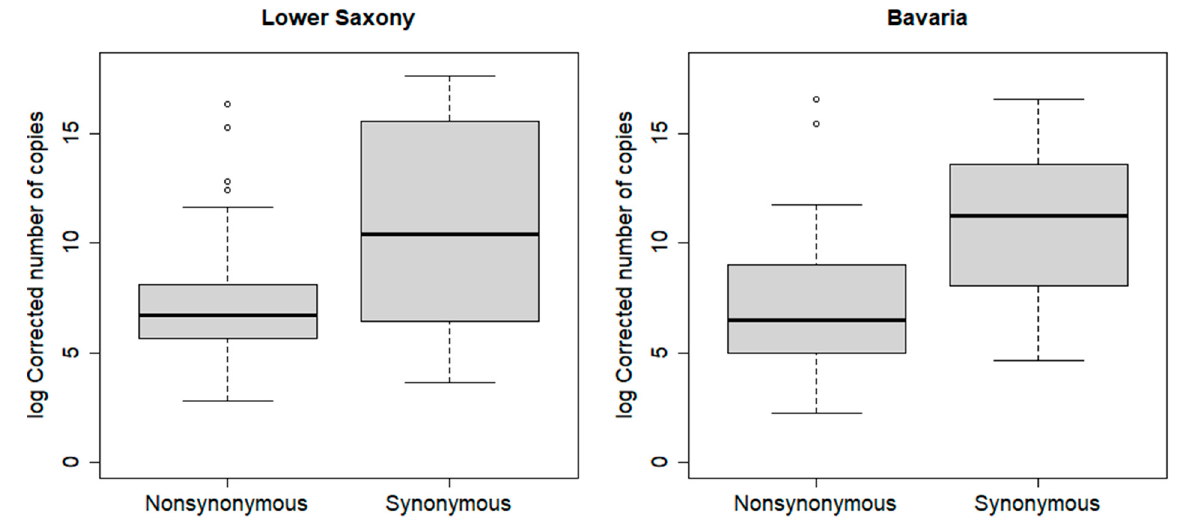
Figure 1. Virus loads measured in synonymous and nonsynonymous virus-tick population pairings. Outliers are represented by circles.